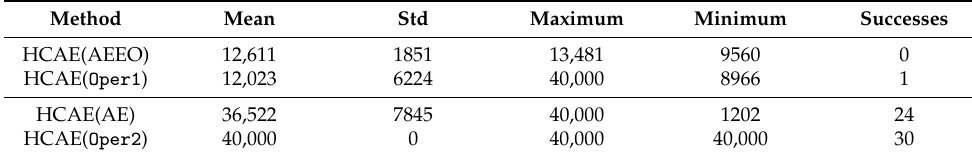
Table 5. Results of the second phase of